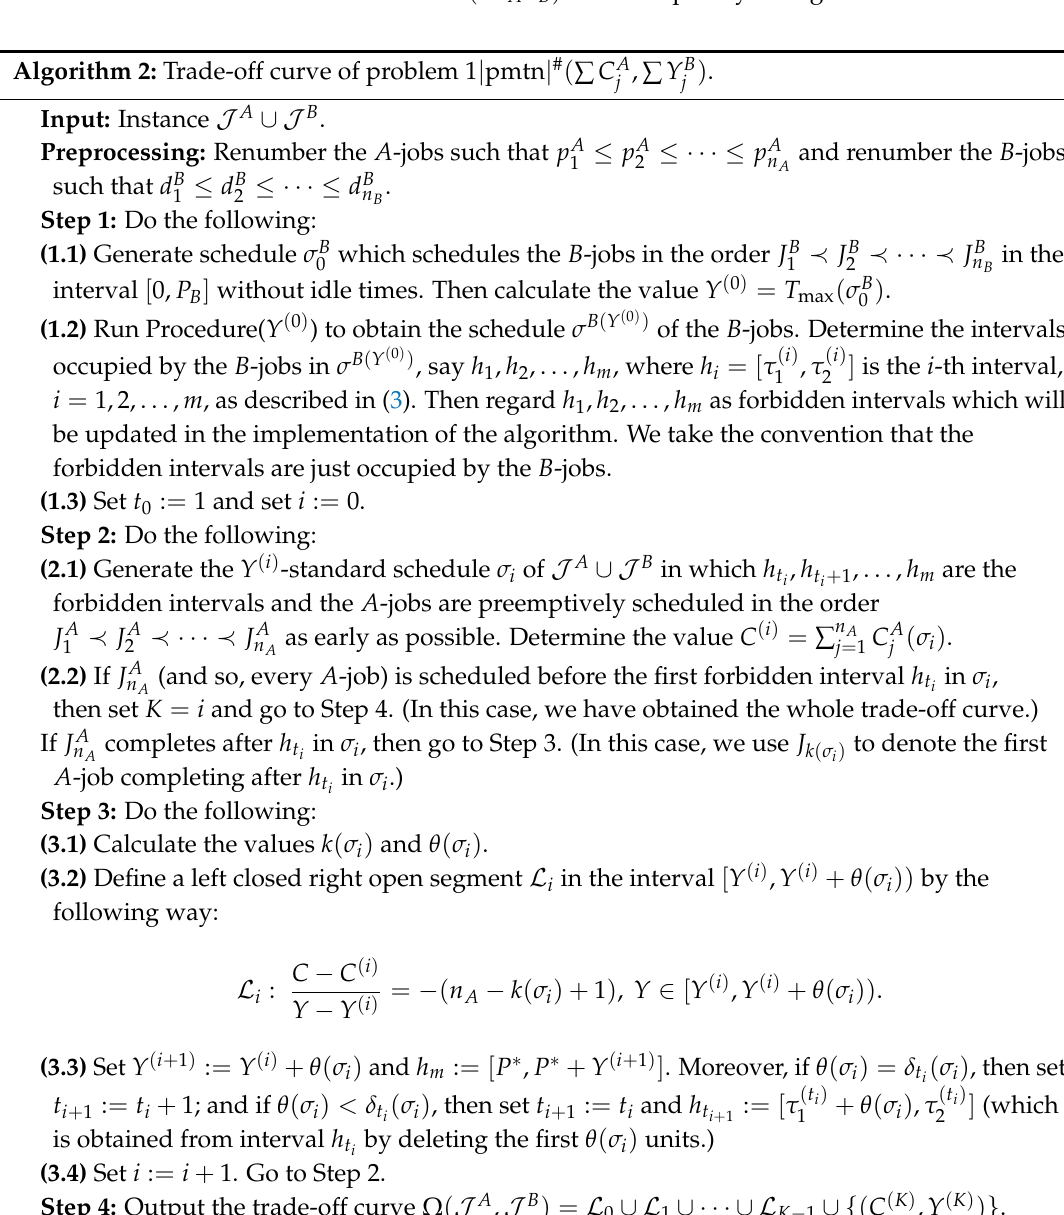
Algorithm 2: Trade-off curve of problem 1 | pmtn | # ( ∑ C A